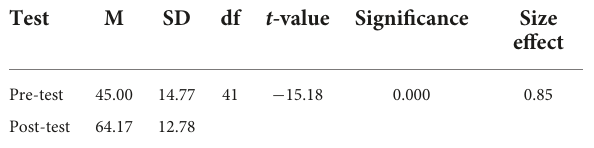
TABLE 2 Results of paired sample t -test for the students’ pre-test and post-test of vocabulary